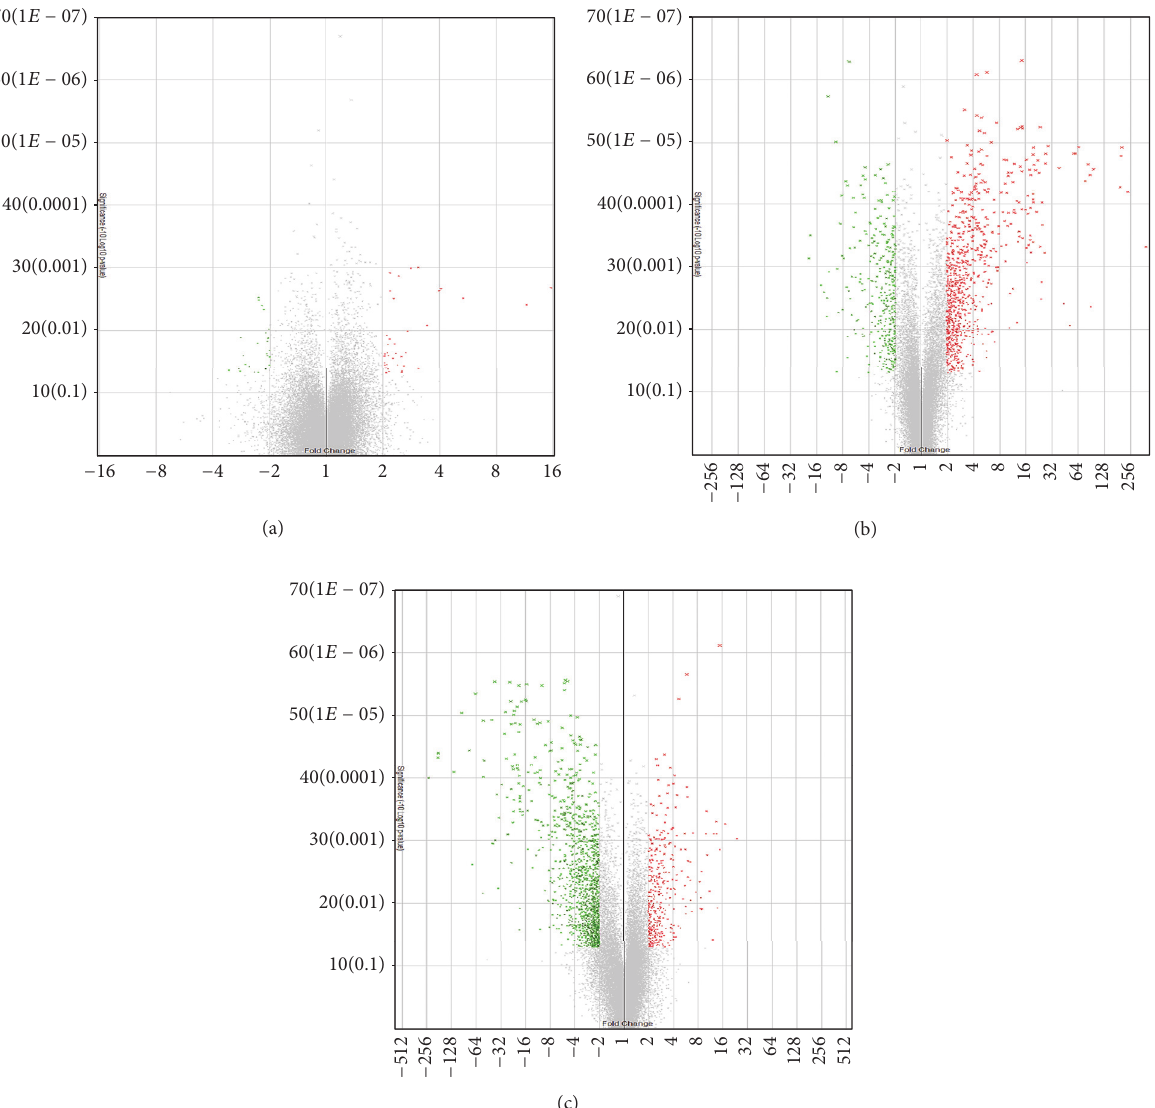
Figure 2: Volcano plots to identify changes in gene expression between (a) MSC-17 versus UT-MSC, (b) MSC- 𝛾 versus UT-MSC, and (c) MSC-17 versus MSC- 𝛾 . Axes of these plots represent significance ( − 10 log10 𝑝 value of the ANOVA 𝑝 values; 𝑦 -axes) versus fold changes (linear fold change from condition pairing; 𝑥 -axes). Red colour indicates upregulated genes and the green represents downregulated genes. The grey region indicates genes that were not differentially expressed and not statistically